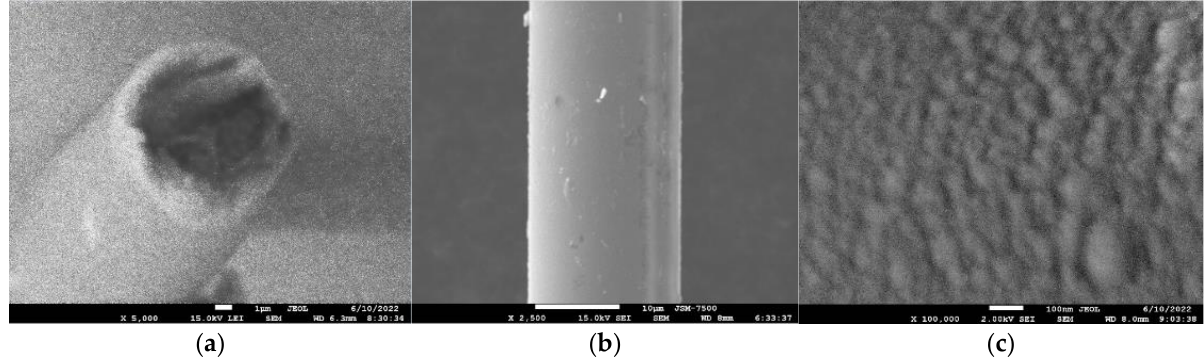
Figure 3. Microstructure of the surface of metallized glass fiber with neusilber film after two sputter- ings: ( a ) fiber projection; ( b ) neusilber film surface at small magnification; ( c ) neusilber film surface at high magnification.